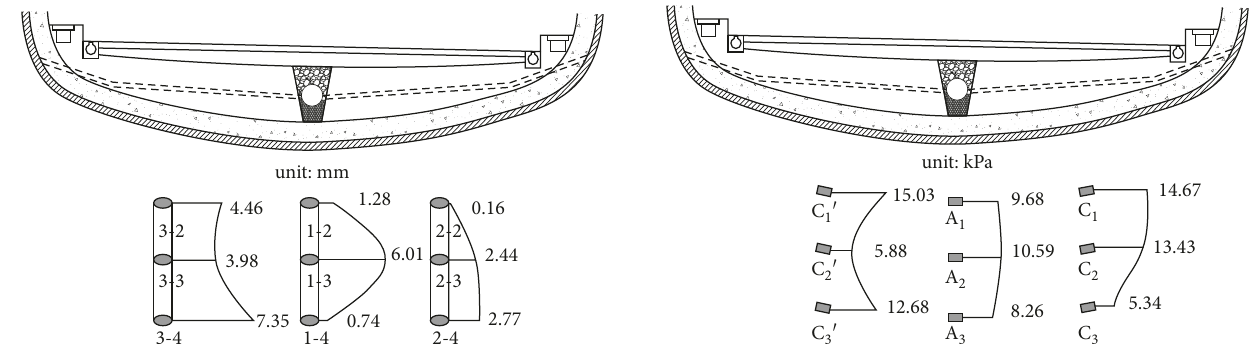
Figure 18: Additional stress of the tunnel foundation. Figure 17: Settlement of tunnel